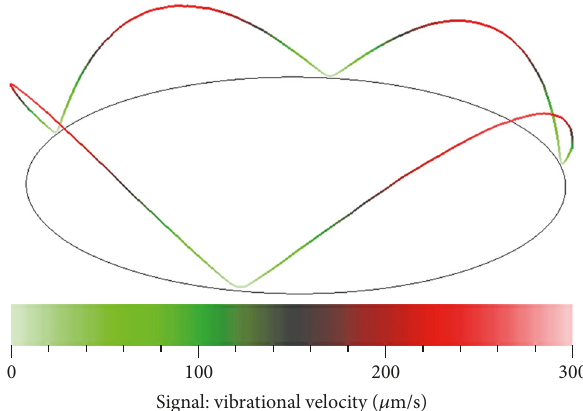
of the piezoelectrodes were 200 𝜇 m, 400 𝜇 m, 600 𝜇 m, and 800 𝜇 m, respectively.